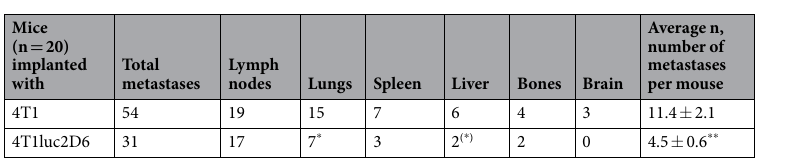
Table 1. Characteristics of the metastatic potential of 4T1 and 4T1luc2D6 cells in the orthotopic breast cancer model evaluated by BLI and confirmed by MRI. ** p < 0,00001 (t-test); * p < 0.05 and ( * ) p < 0.1